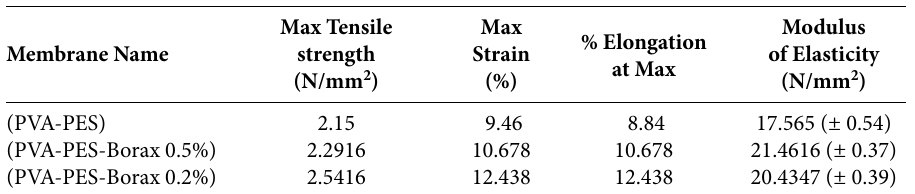
Table 3. Mechanical Property of PVA-PES composite membranes cross linked with borax. (The figures in the bracket in column 5 indicate standard deviation.)